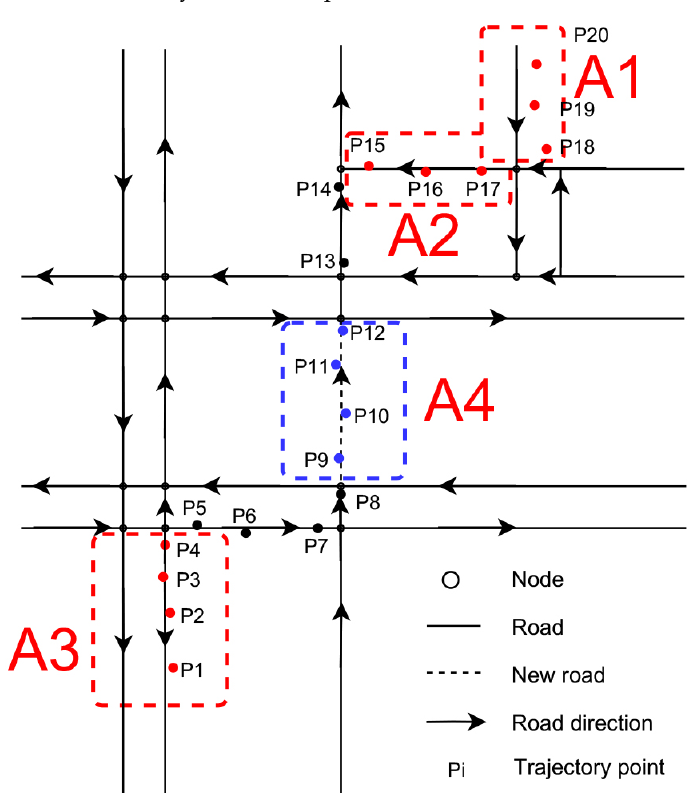
Figure 3. Update region identification. A1, A2, and A3 represent the problematic road segment regions. A4 represents the new road segment